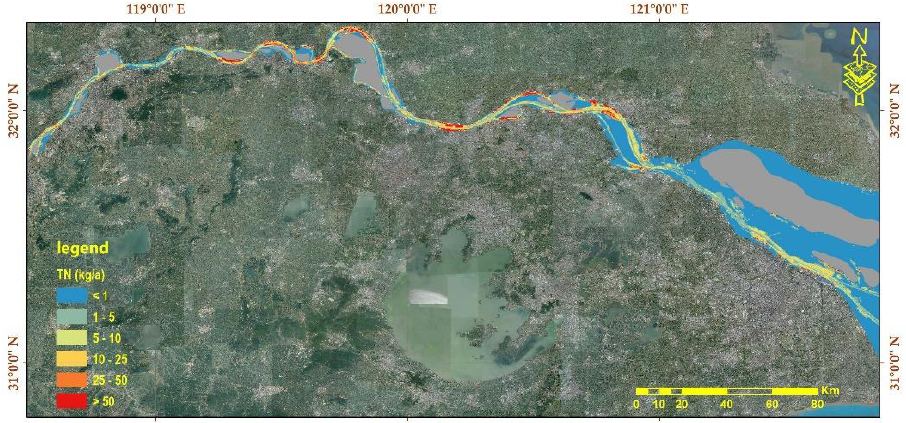
Figure 10. SS generations distribution.